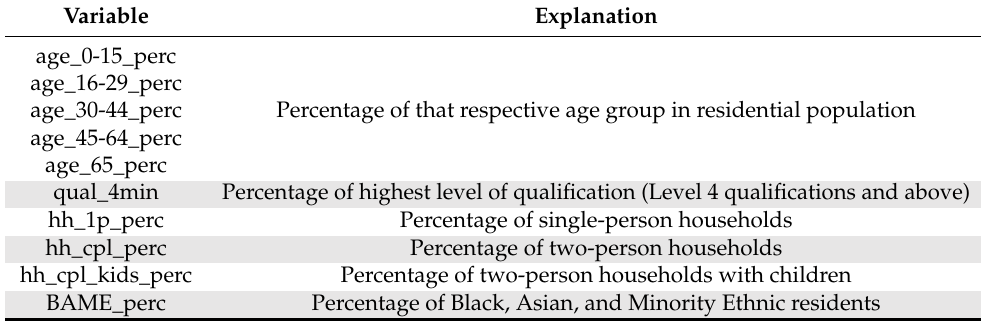
Table 1. Census variables